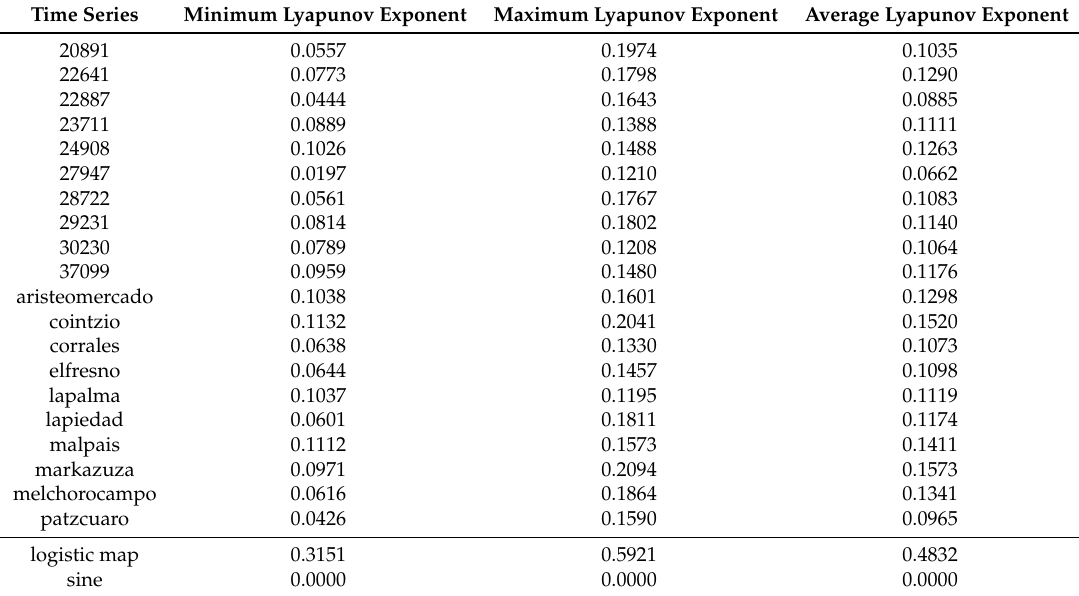
Table 1. Dominant Lyapunov